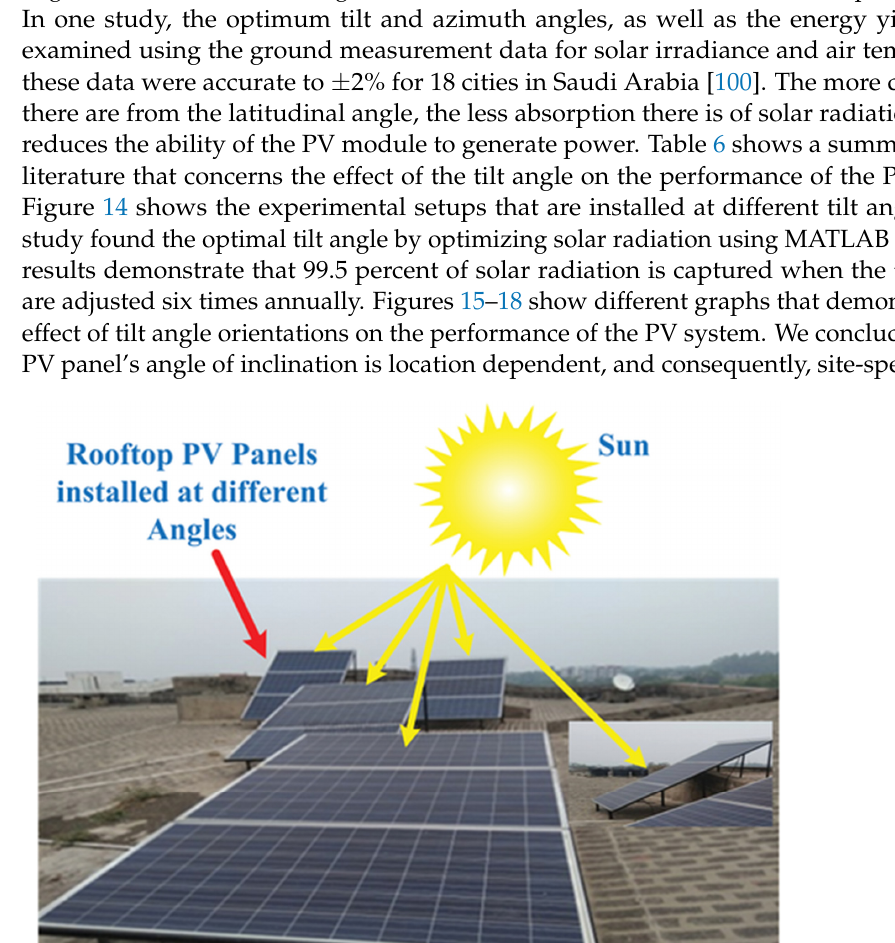
Figure 15. Peak power (watt) with time (day index) for the three PV panels [103].